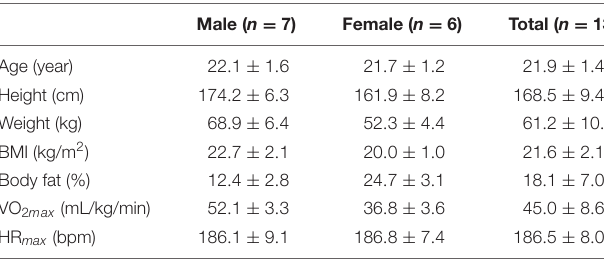
TABLE 1 | Demographic characteristics of the